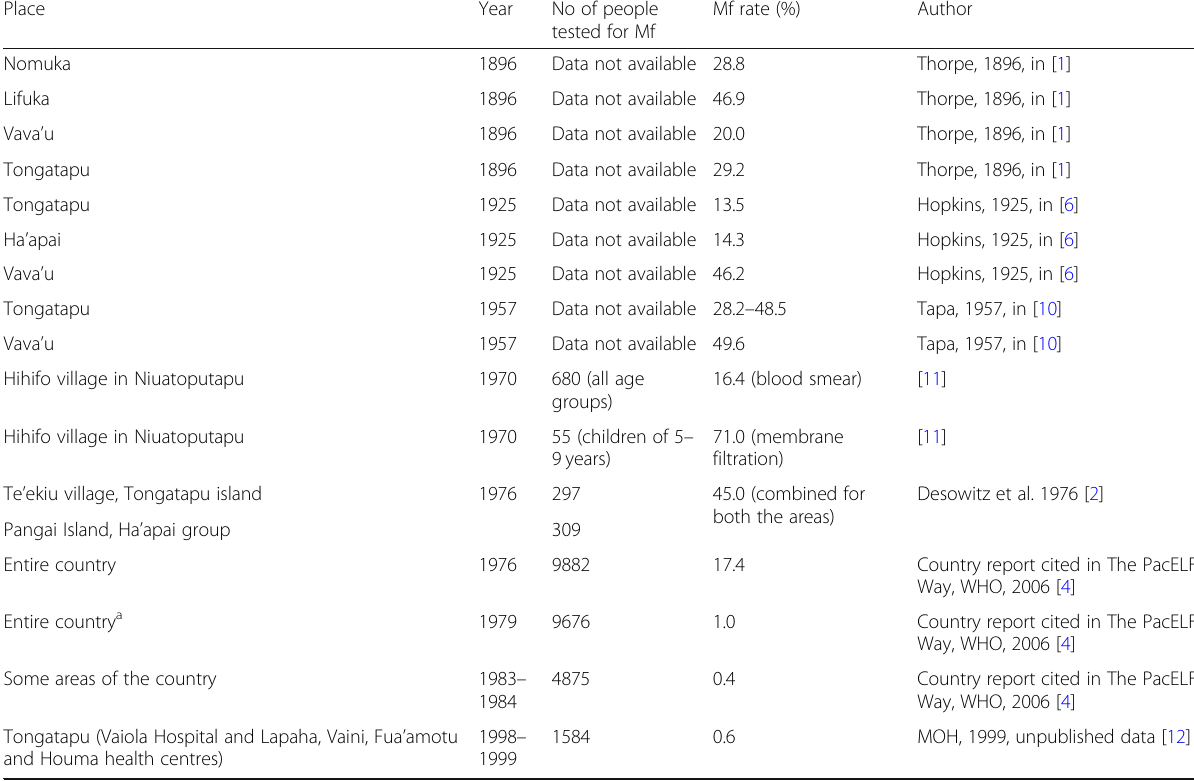
Table 2 The Mf rate and disease rate reported from various studies in Tonga